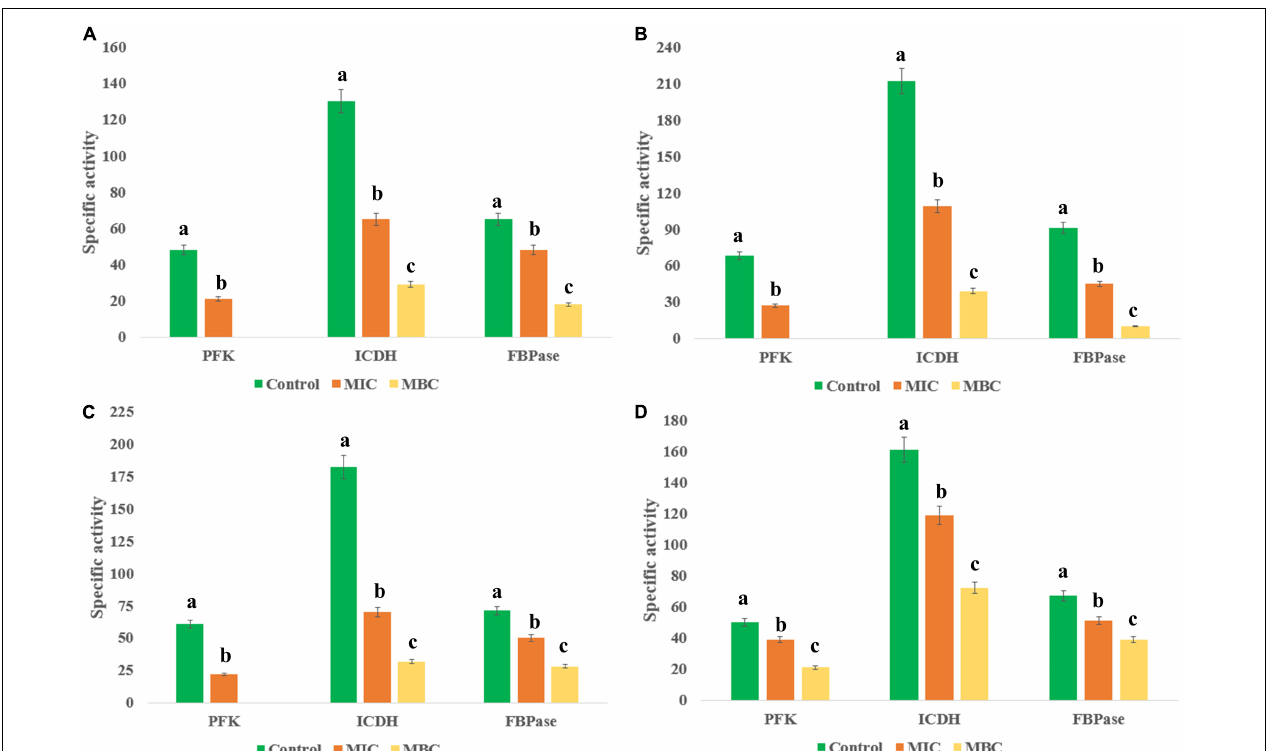
FIGURE 4 | Effect of different concentrations of HelS1 ethyl acetate (EA) extract on the essential enzymes of microorganisms ( A MRSA, B L. monocytogenes , C V. parahaemolyticus , and D P. aeruginosa ) involved in central energy (carbohydrate) metabolism. Values on the graphs are the means ± standard error (SE) of the three replicates. Tukey’s multiple comparison test was performed. The different letters a, b, and c in each case [Control, MIC, minimum bactericidal concentrations (MBC)] represent a significant difference between them (At, p < 0.05).